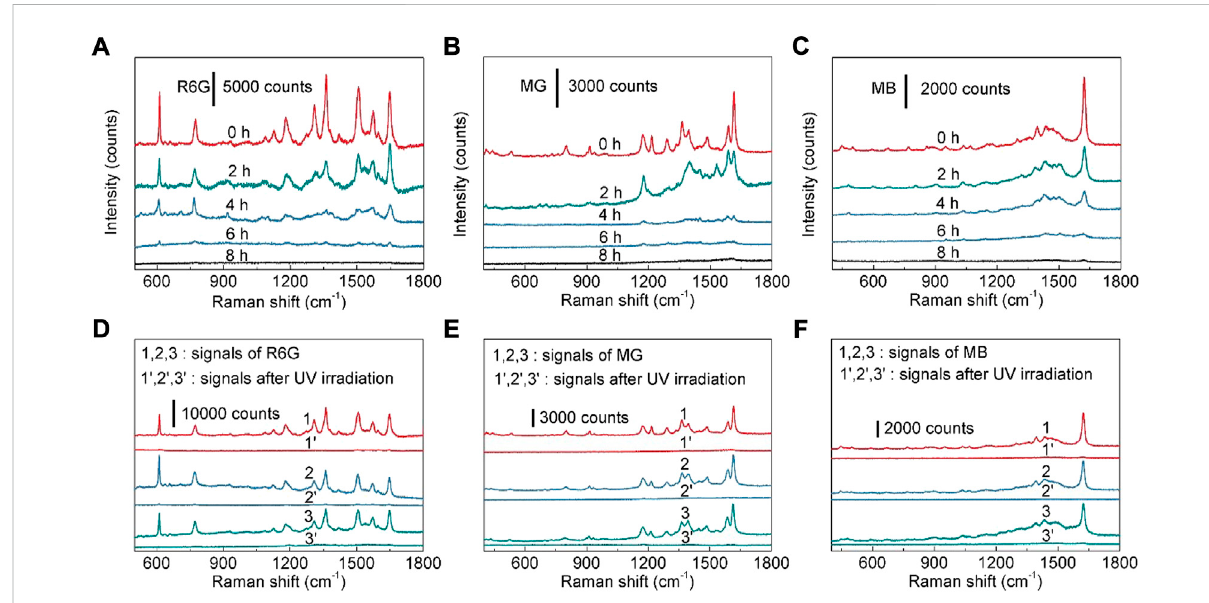
FIGURE 6 (A) SERS spectra of R6G (10 − 7 M) collected from the as-prepared Ag nanoparticles modi fi ed TiO 2 nanotube arrays after UV irradiation for 0 – 8 h (B) SERS spectra of MG (10 − 5 M) collected from the as-prepared Ag nanoparticles modi fi ed TiO 2 nanotube arrays after UV irradiation for 0 – 8 h (C) SERS spectra of MB (10 − 5 M) collected from the as-prepared Ag nanoparticles modi fi ed TiO 2 nanotube arrays after UV irradiation for 0 – 8 h (D) SERS spectra of R6G (10 − 7 M) during three self-cleaning cycles. (E) SERS spectra of MG (10 − 5 M) during three self-cleaning cycles. (F) SERS spectra of MB (10 − 5 M) during three self-cleaning